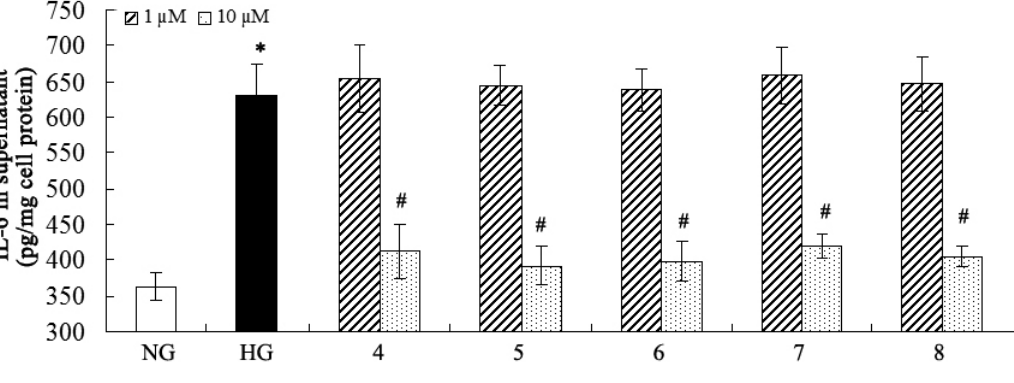
Figure 5. Inhibitory effect of the compounds on IL-6. * p < 0.05 vs . normal glucose; # p < 0.05 vs. high